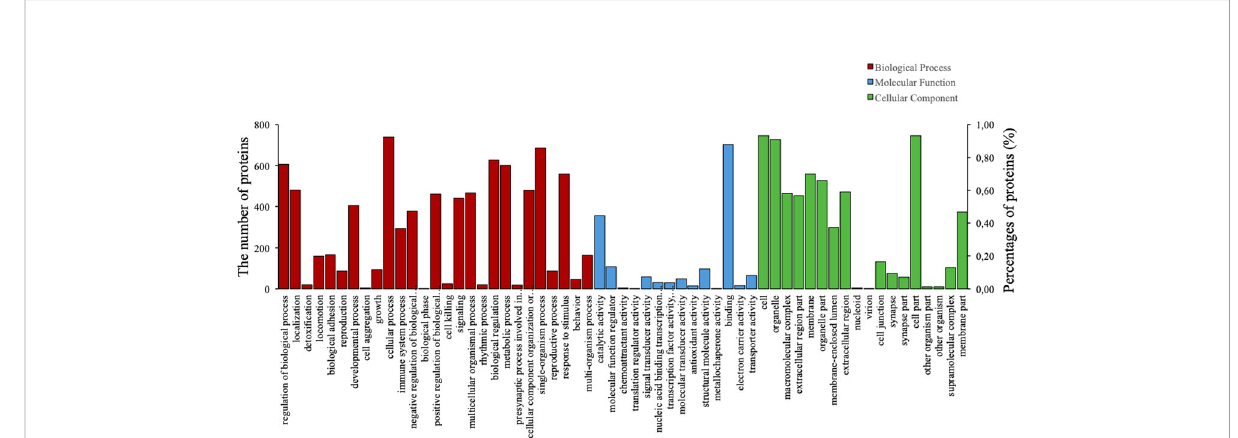
FIGURE 2 Gene Ontology (GO) analysis results of differentially expressed proteins in AMH tissues compared with adjacent control tissues. Analyses were performed using three terms: biological process (BP), molecular function (MF), and cellular component